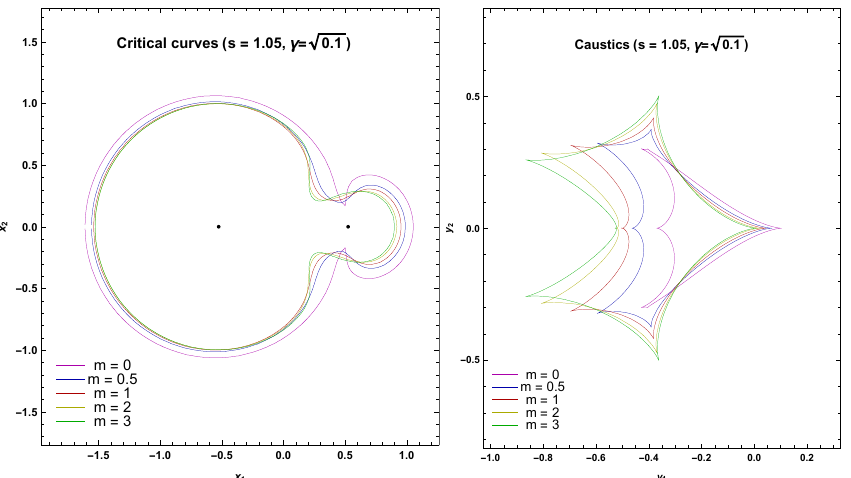
Figure 9. Critical curves and caustics in the unequal-strength binary, intermediate separation.